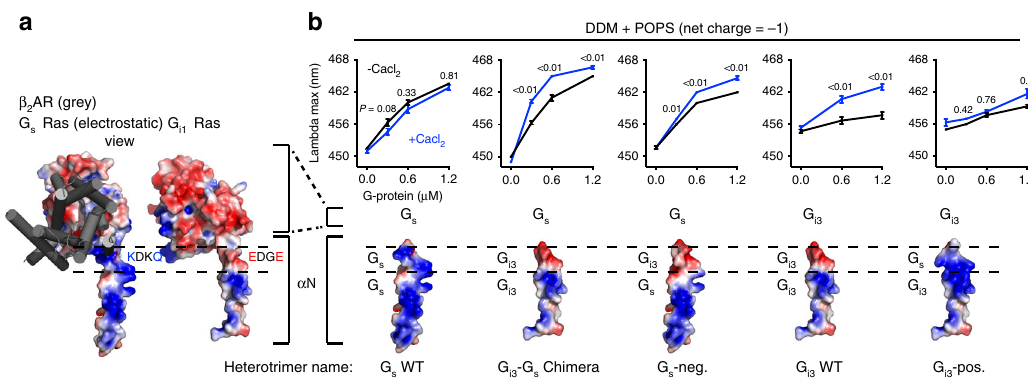
Fig. 3 Ca 2 + interacts with the amino terminal helix of G i3 . a Membrane-facing surfaces of G s and G i1 Ras domains, with β 2 AR shown in gray. The membrane-facing surface of G i1 was modeled by superimposing the Ras domain of G i1 (PDB: 1GP2 70 ) onto the structure of G s in complex with β 2 AR (PDB: 3SN6 69 ). Red and blue signify negative and positive charge on G protein, respectively. Dashed lines highlight the region in α N where charge differs: The sequence is KDKQ in WT G s vs. EDGE in WT G i1 (and in G i2 , G i3 ). b mB − β 2 AR − G protein dose − response curves ± 10 mM CaCl 2 . Data were generated with the G protein depicted below the curves: mutations were made in α N and corresponding electrostatic models are shown. Epinephrine was not included in experiments titrating G s WT, G i3 -G s Chimera, or G s -neg. to enhance the effect of CaCl 2 . Epinephrine (100 μ M) was included in experiments titrating G i3 WT and G i3 -pos. mB − β 2 AR concentration is 250 nM. Data are mean ± s.e.m. of three independent experiments. Multiplicity adjusted P values were computed by two-way ANOVA followed by Sidak ’ s post hoc test between CaCl 2 conditions. Source data are provided in the Source Data File